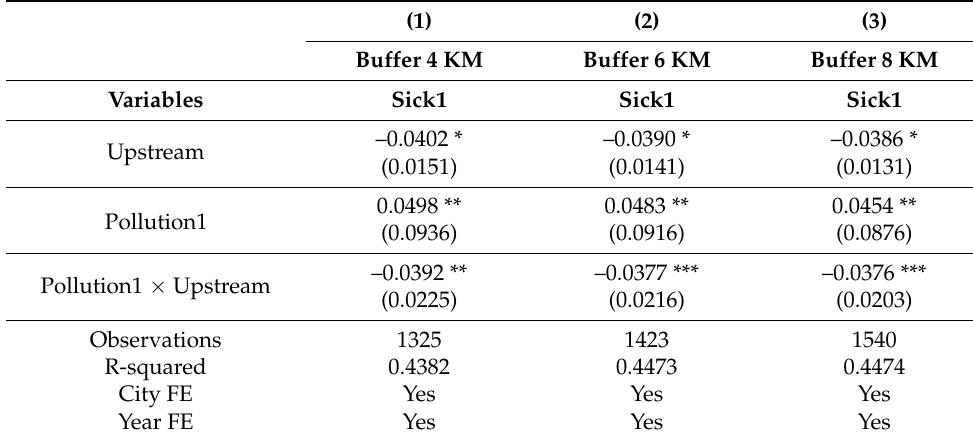
Table A6. Effects of pollutants on residents’ health.